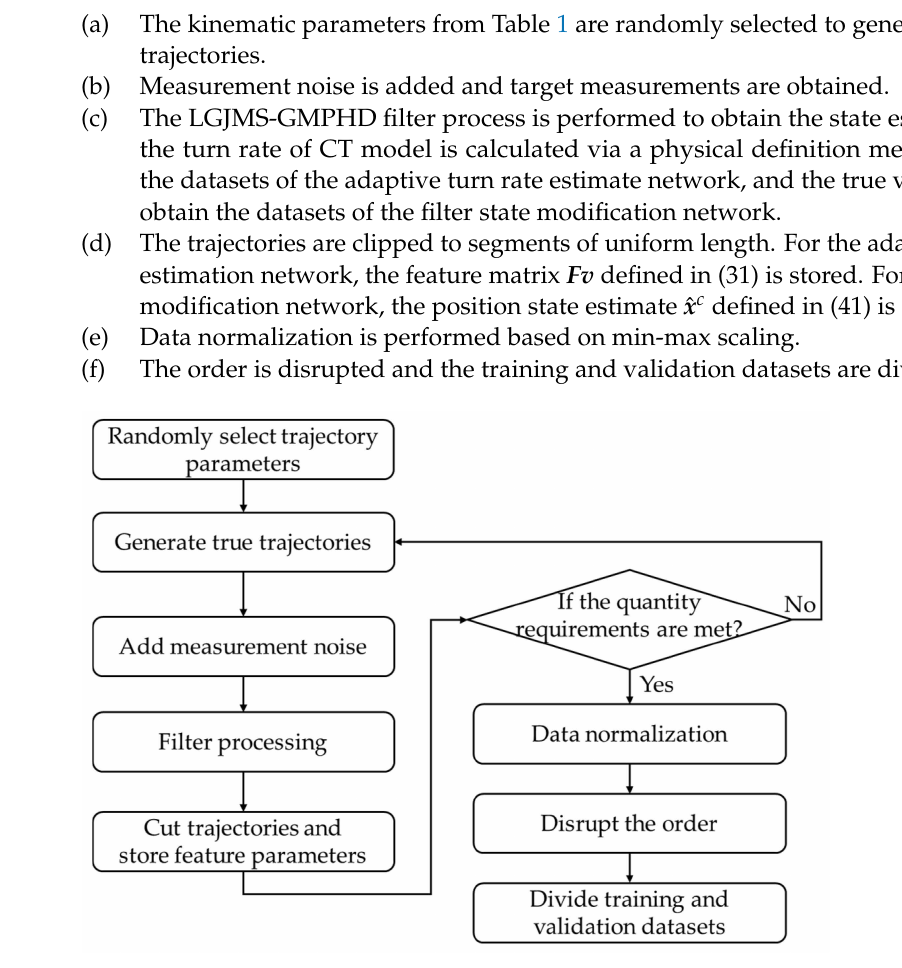
Figure 5. Flowchart of dataset